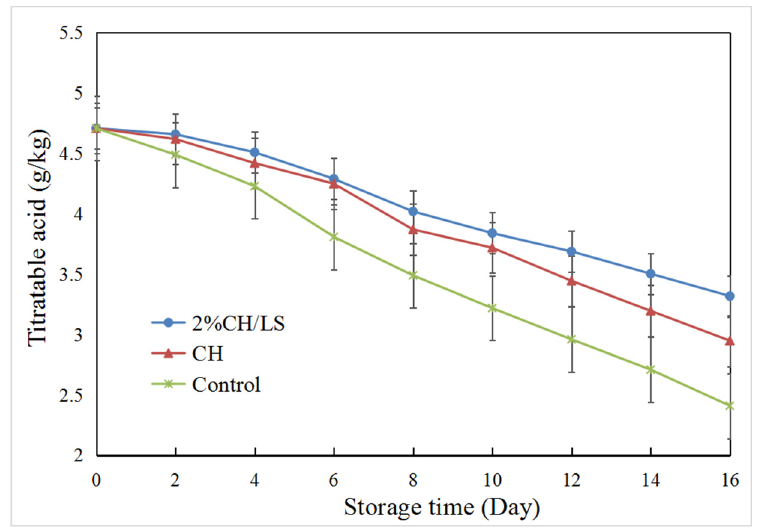
Figure 5. Titratable acid of grapes during preservation with different packaging films.